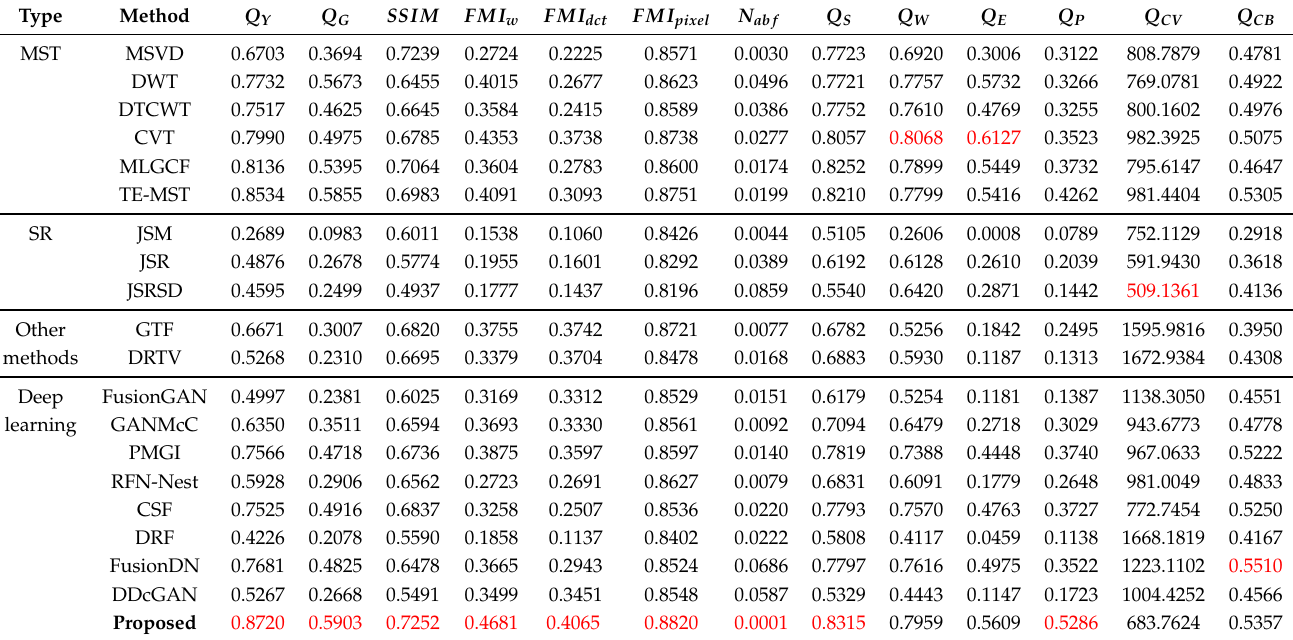
Table 5. The average values of different methods on the RoadScene